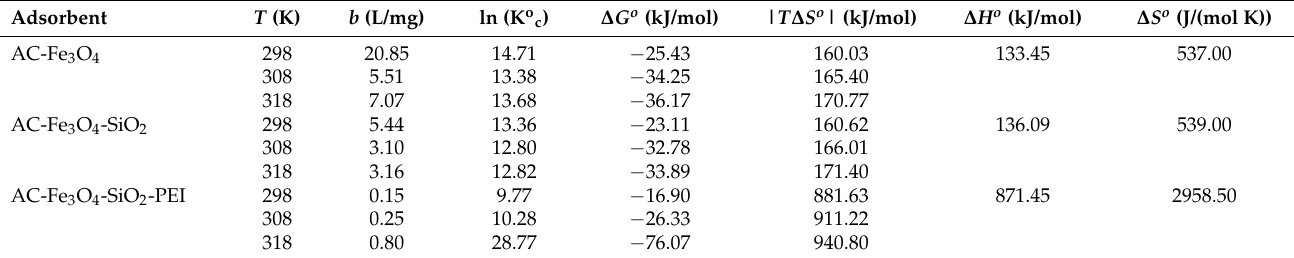
Table 5. Thermodynamics parameters of AC-Fe 3 O 4 , AC-Fe 3 O 4 -SiO 2, and AC-Fe 3 O 4 -SiO 2 -PEI at different temperatures.